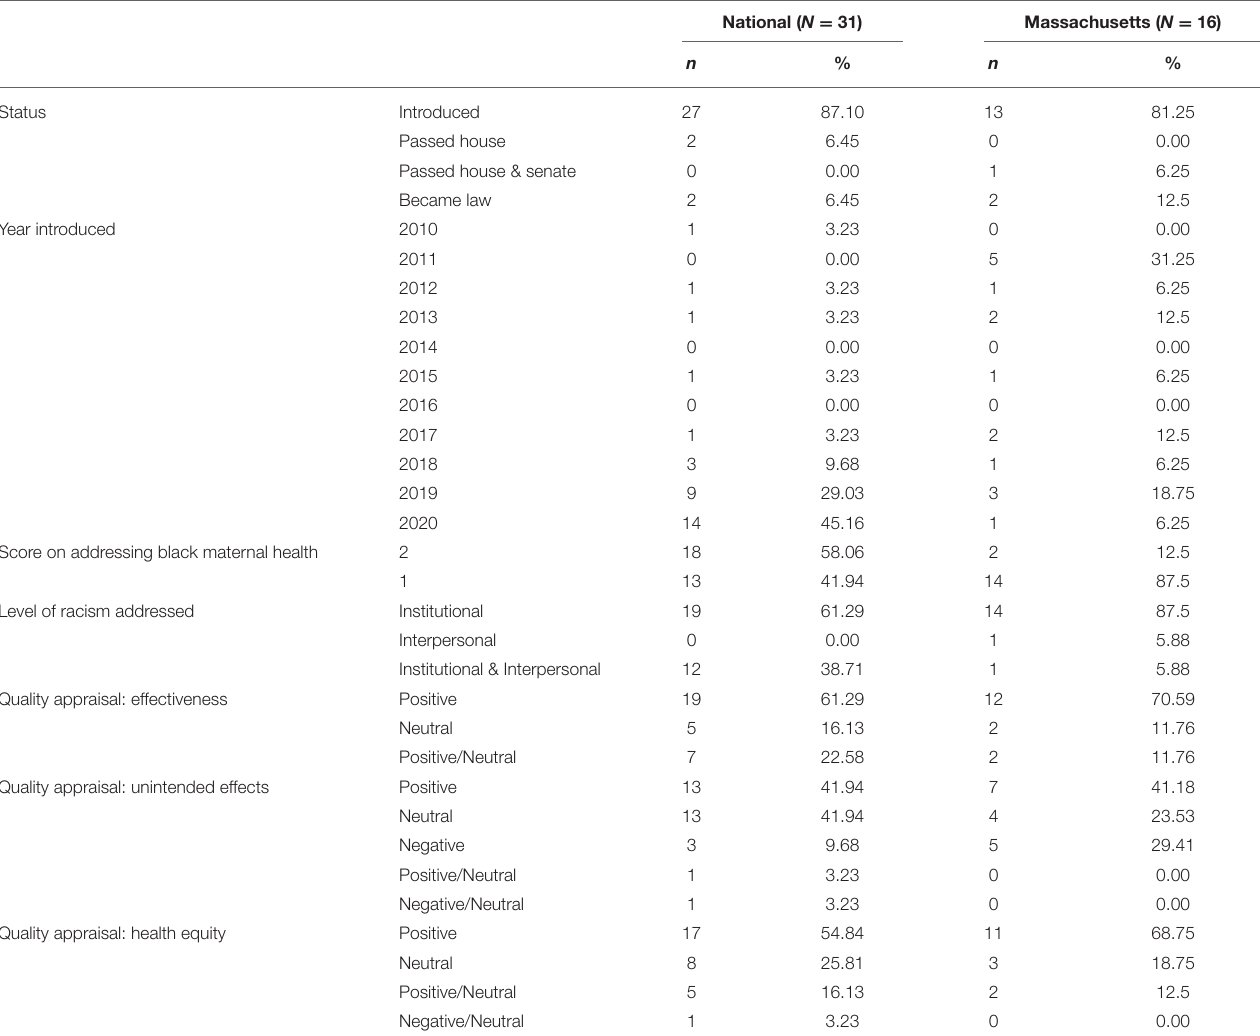
TABLE 2 | Characteristics and quality appraisal of included national and Massachusetts state-level